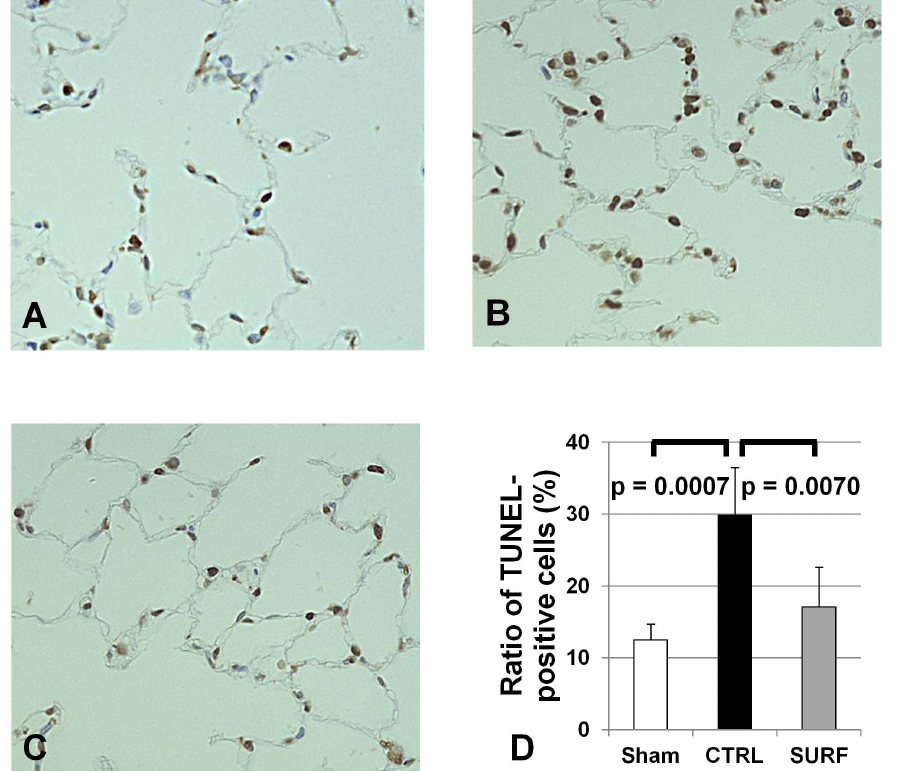
Figure 7. TUNEL assay (original magnification 400 6 ). (A) Sham group. (B) CTRL group. (C) SURF group. The ratio of apoptotic cells to total cells in the Sham and SURF groups was significantly lower than that in the CTRL group (D). All values are expressed as the mean 6 SD.